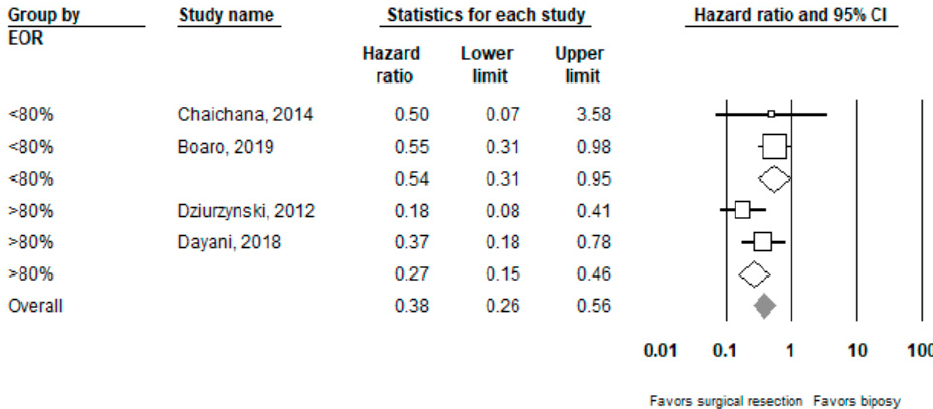
Figure 3. Forest plots showing hazard ratios of surgery vs. biopsy for overall survival stratified by EOR ( ≥ 80% vs. <80%).